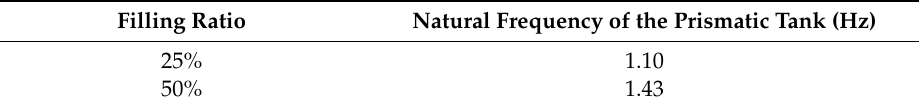
Table 5. Natural frequencies of the prismatic tank at di ff erent filling ratios. Filling Ratio Natural Frequency of the Prismatic Tank